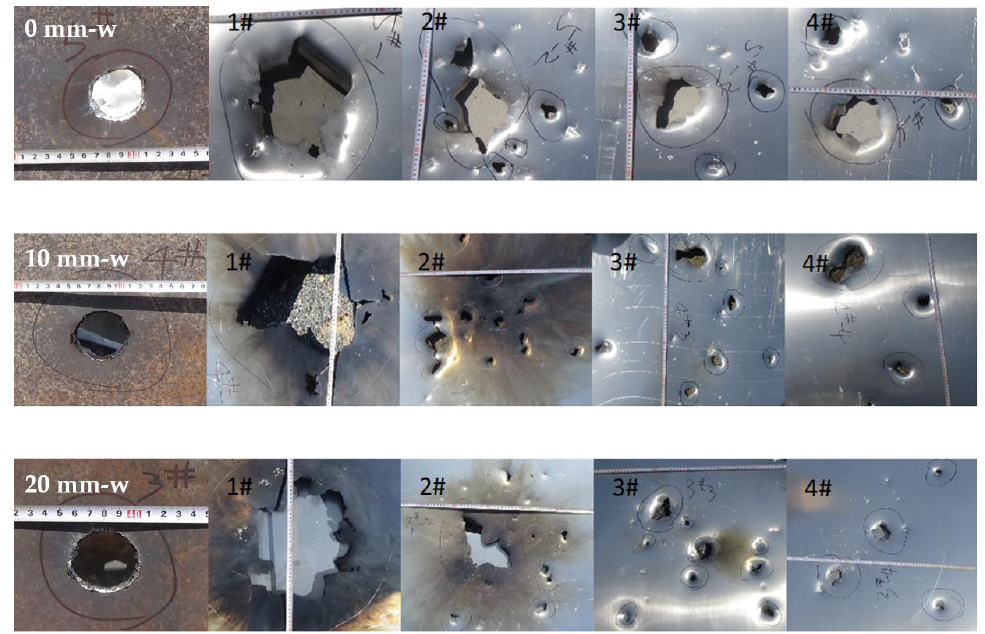
Figure 16. Results of multi-layer spacer board damage with different metal block thicknesses. Table 3. Experimental results.